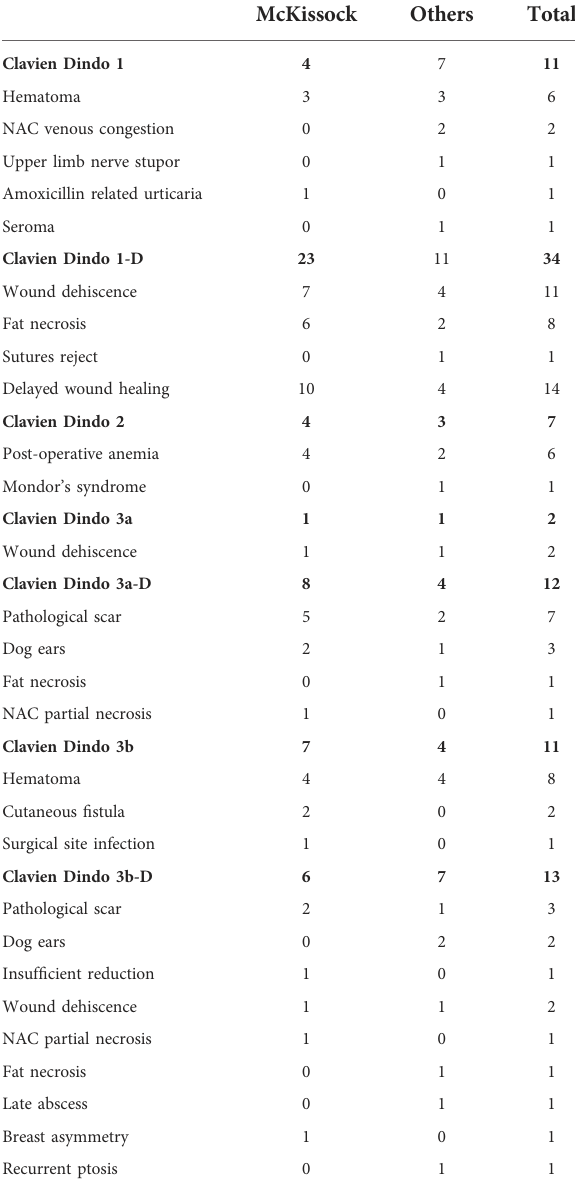
TABLE 1 Detailed total